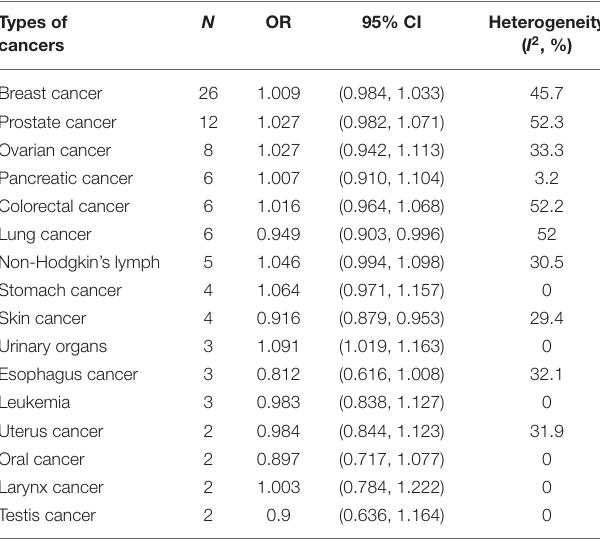
TABLE 2 | Meta-analyses on the associations between night-shift work and each type of cancers. Types of cancers